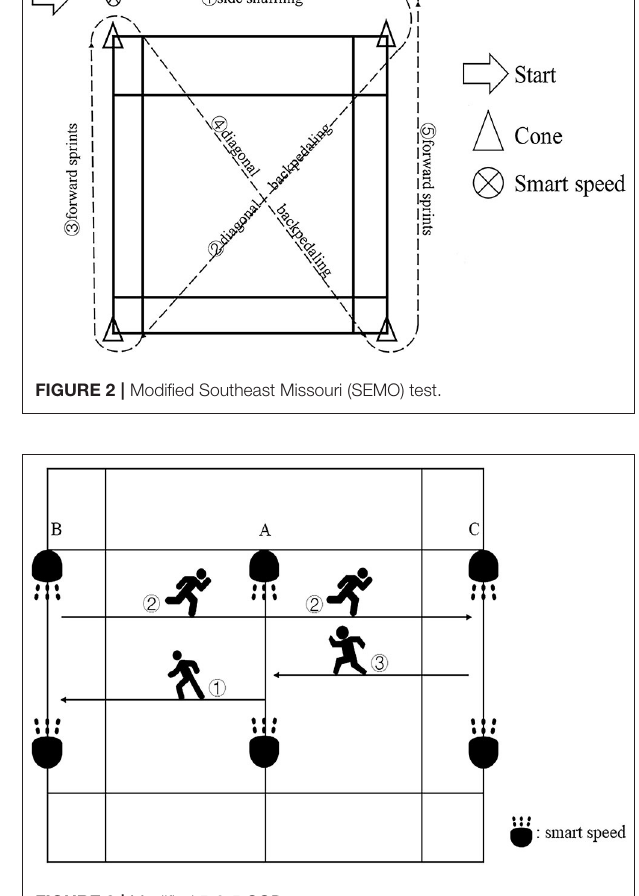
FIGURE 3 | Modified 5-0-5 COD